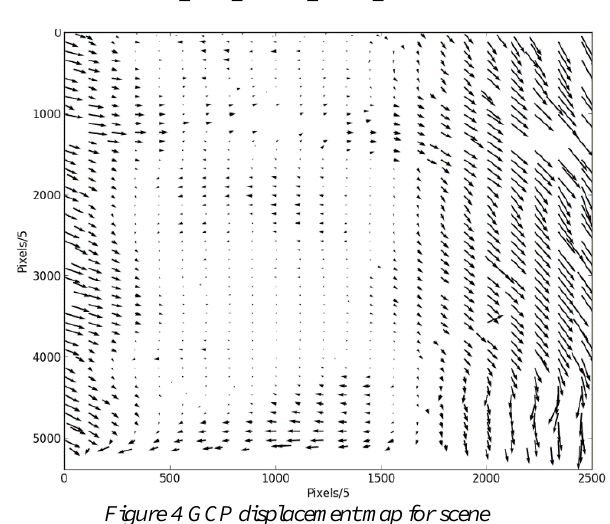
Figure 5 RMS of GCPs Cross Track for ZY3 scene (ZY3_TLC_E111.6_N34.6_20130628). Left -- by the original RPC; Right – by the computed